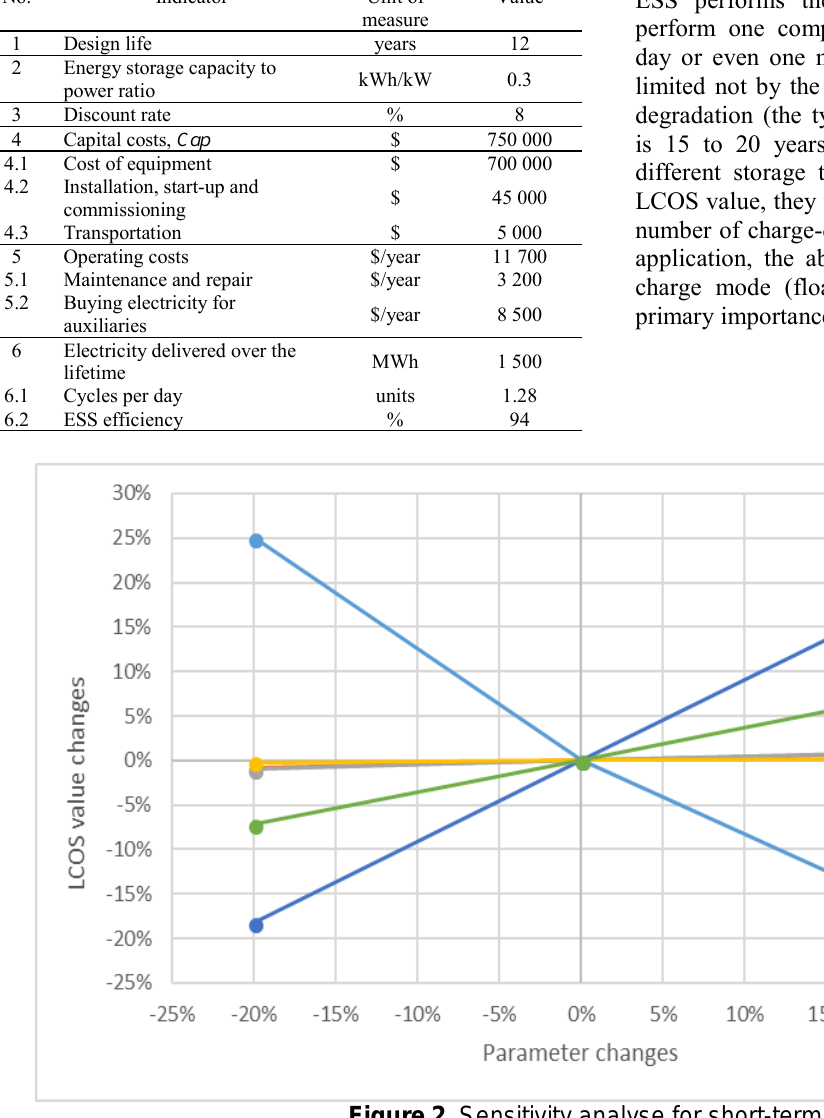
Figure 2 . Sensitivity analyse for short-term